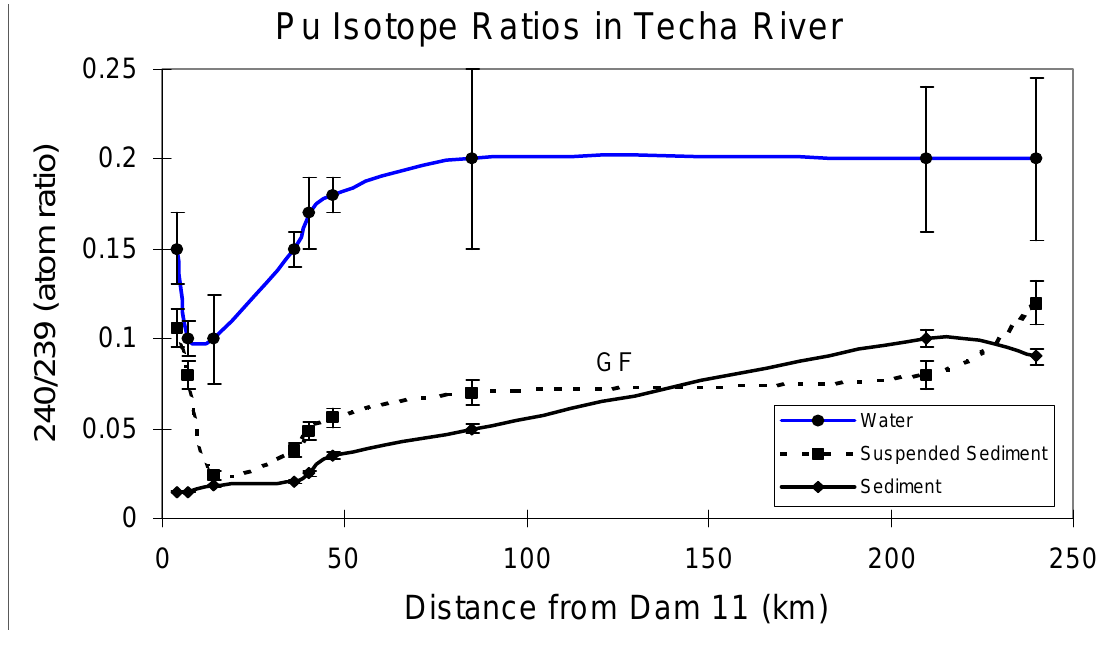
FIGURE 5 . 240 Pu/ 239 Pu atom ratios in surface sediments (0–2 cm), suspended sediments (>0.45 µ m), and